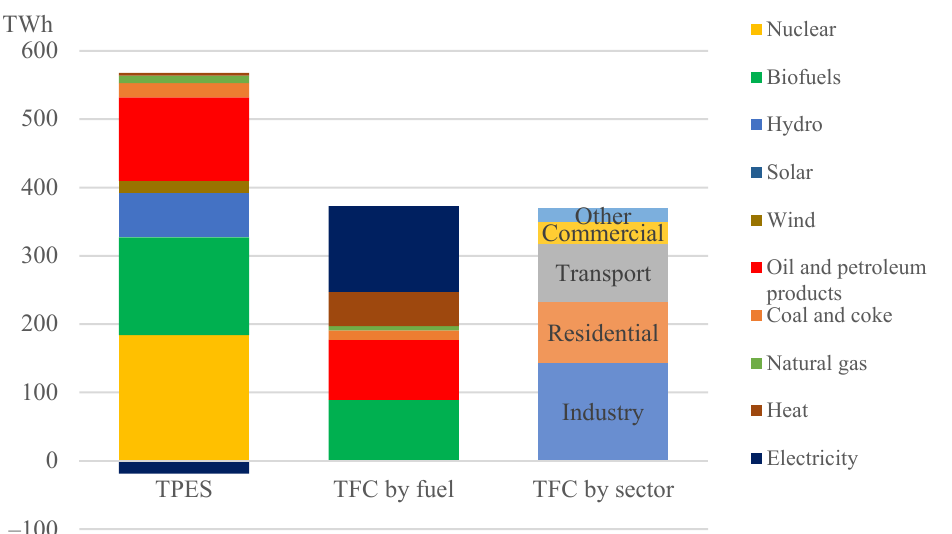
Figure 1. Overview of TPES and TFC by fuel and sector in 2018. Source: Swedish Energy Agency [40].